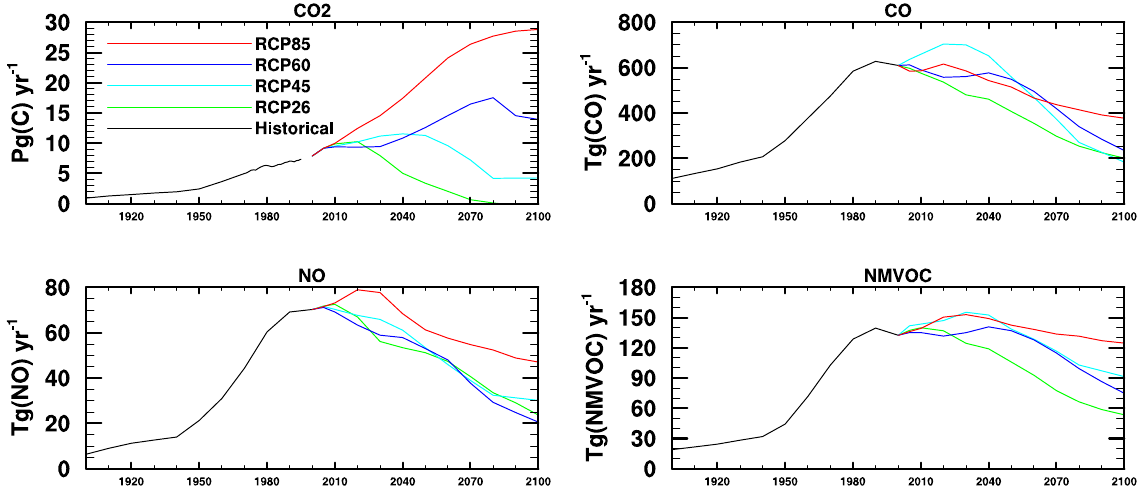
Fig. 1. 200yr timeseries of global anthropogenic emissions for CO 2 , CO, NO, and NMVOC.